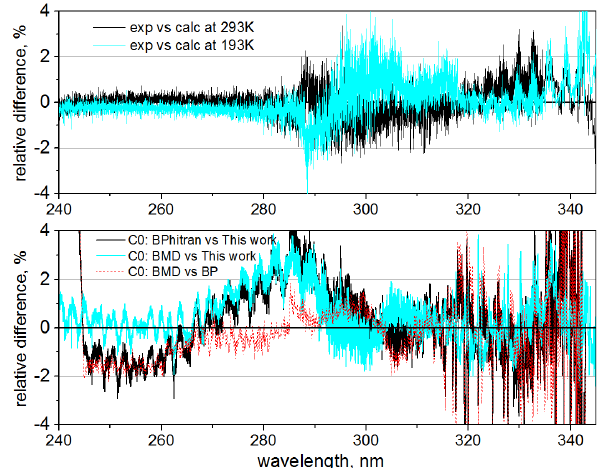
Fig. 5. Temperature dependence of the ozone absorption cross- sections. (upper panel) Difference between the experimental and Eq. (1) for 193 and 293K (light and dark lines). (lower panel) Dif- ference between fitting coefficients C 0 in Eq. (1) from this work and BP (dark line) and BMD (light line), and between BP and BMD (dashed